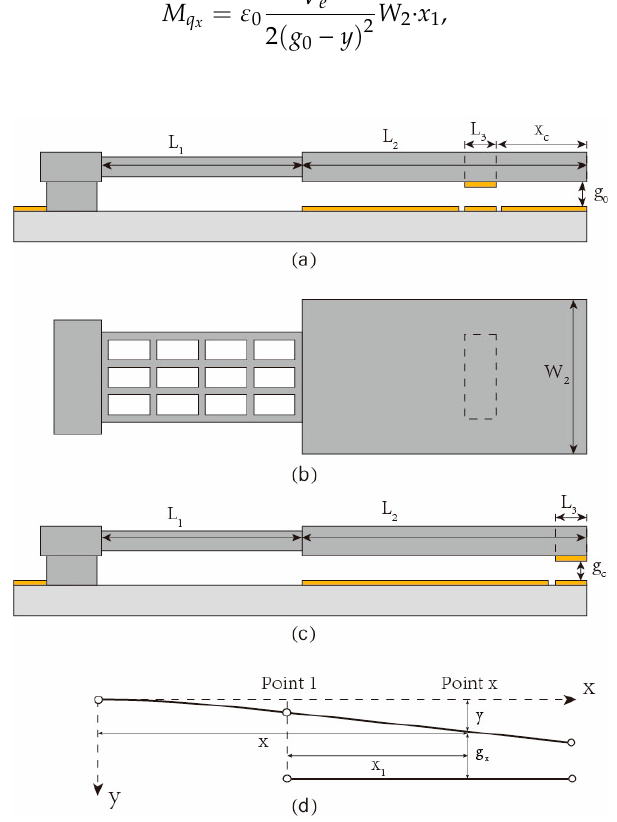
Figure 2. The equivalent parameters of the proposed MEMS relay: ( a – c ) Dimension marking of geometric parameters for the cantilever; ( d ) establishment of coordinate for geometric parameters.